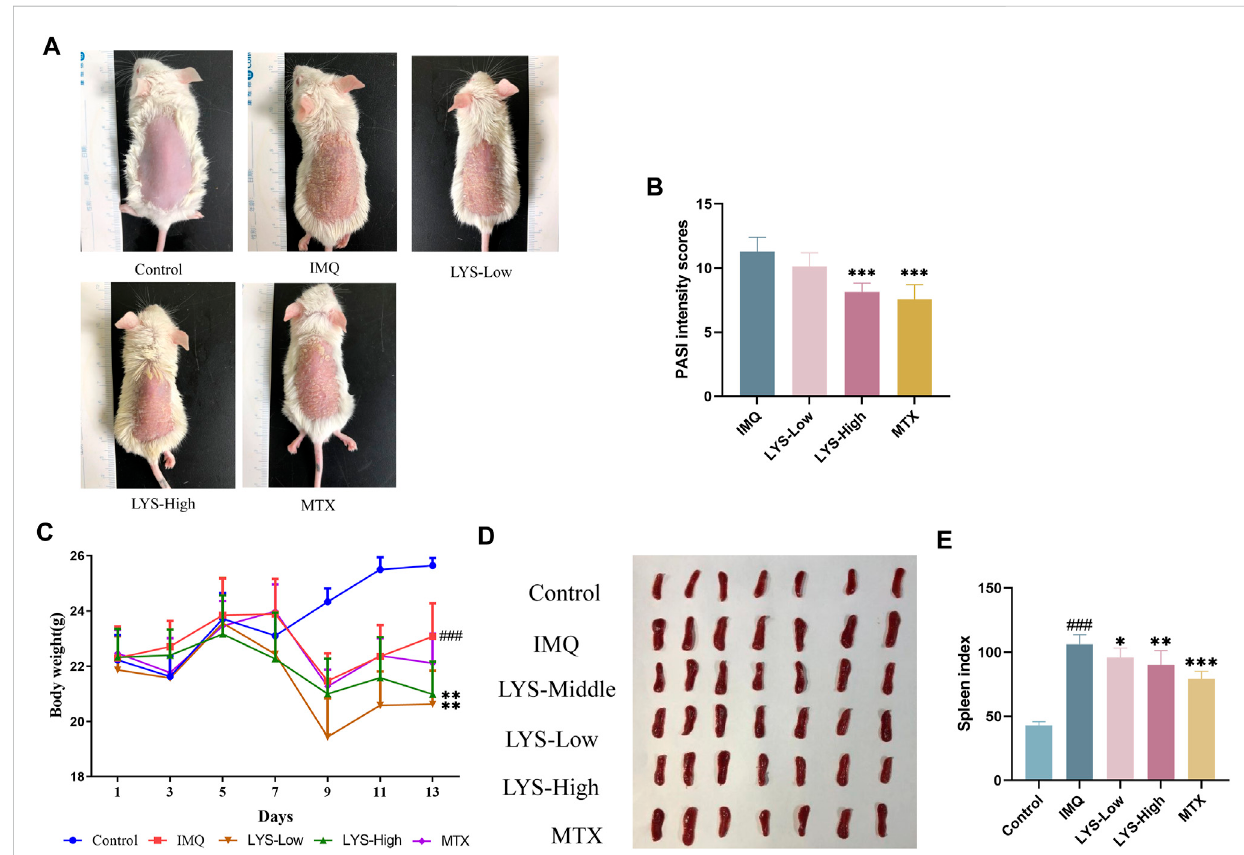
FIGURE 2 Effects of LYS treatment against psoriasis-like symptoms ( n = 7). (A) Images of psoriatic skin lesions in fi ve different groups. (B) PASI intensity scores of skin lesions in fi ve different groups. (C) Changes in body weight in mice. (D) Spleen images and (E) cumulated spleen index in fi ve different